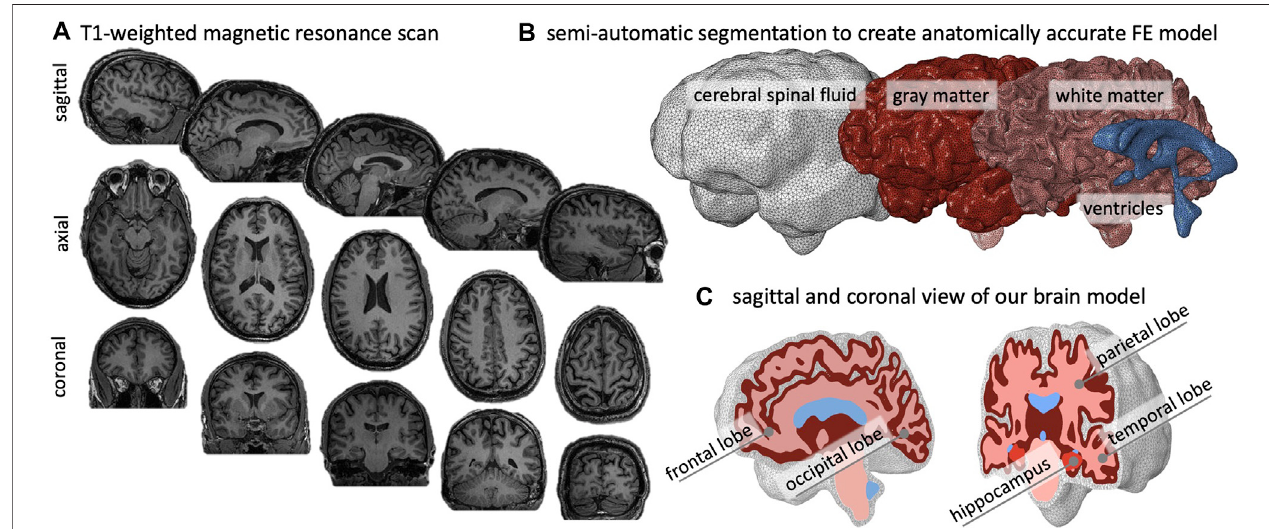
FIGURE 2 | We create an anatomically accurate fi nite element model of the brain based on semi-automatic segmentation of a T1-weighted MRI. (A) The brain ’ s primary cortical and subcortical structures, as well as fl uid volumes, are clearly visible in the representative sagittal, axial, and coronal slices shown here. (B) For the brain, we reconstruct the ventricles, white matter (WM), and gray matter (GM); we encase GM by cerebrospinal fl uid (CSF) and approximate the skull by imposing zero-displacement boundary conditions on the CSF ’ s outer surface. (C) We create the GM layer by projecting the WM surface outward; this approach minimizes self-contact of the outer GM surface and provides an FE mesh that does not prevent sulcal widening due to shared nodes on the GM surface.